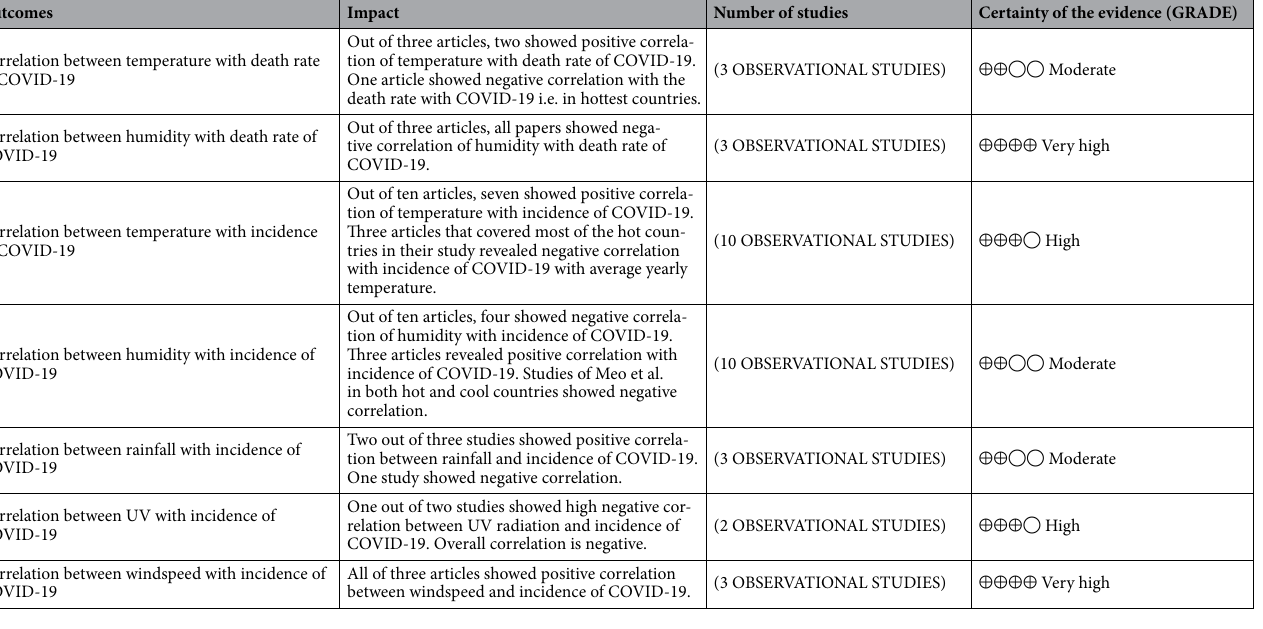
Table 3. GRADE evidence profile